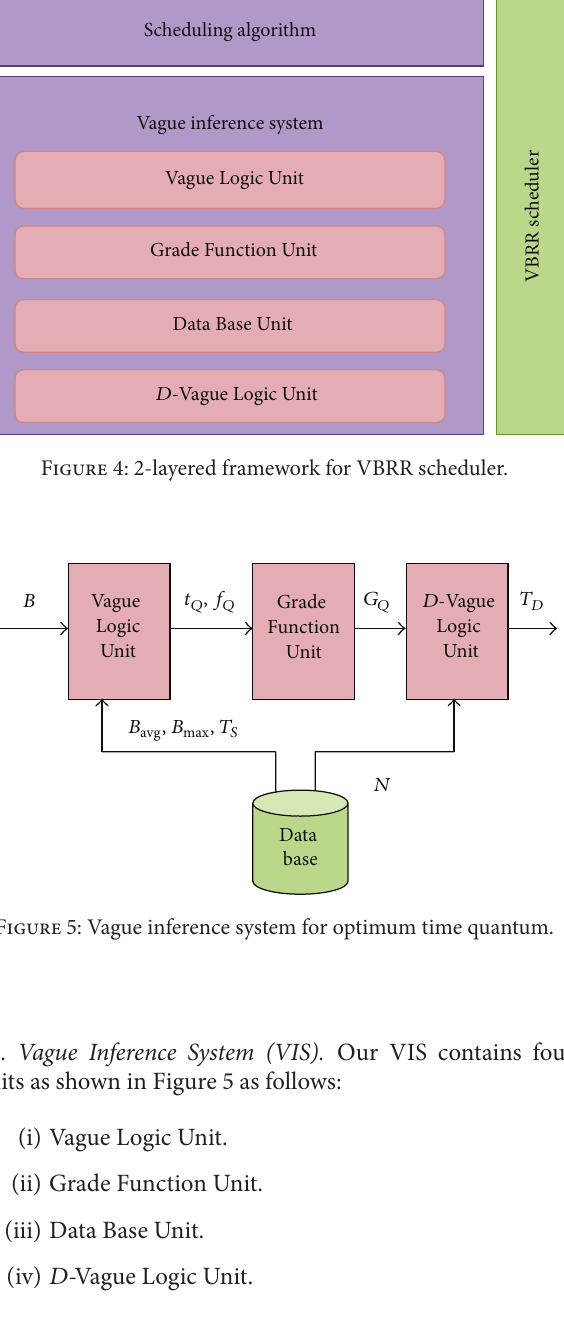
Figure 5: Vague inference system for optimum time quantum.